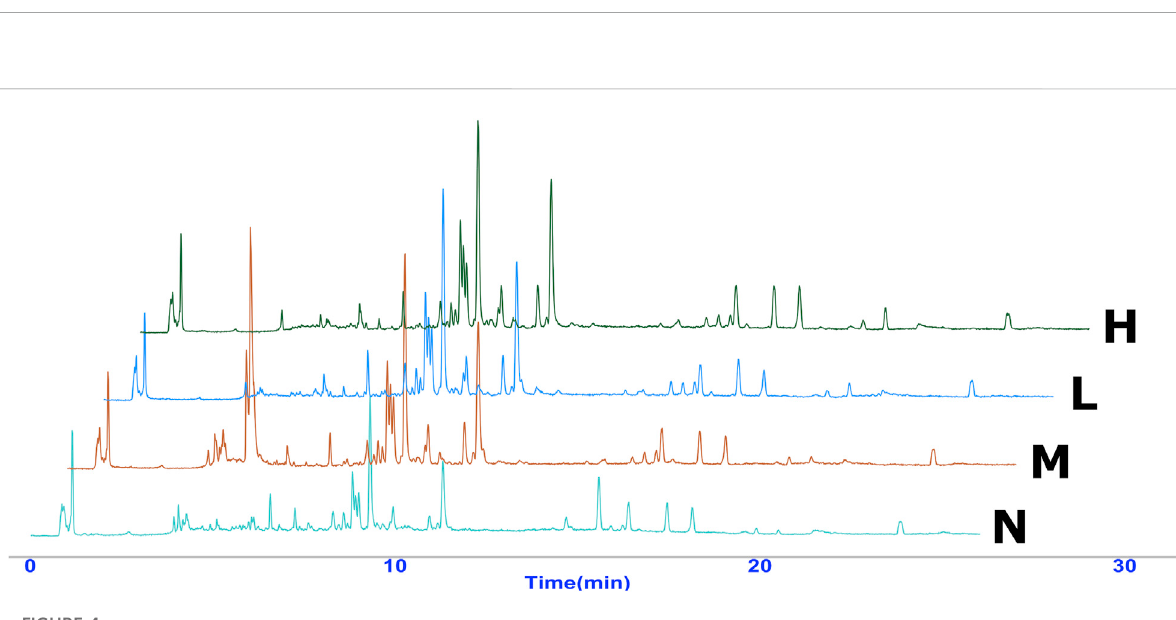
FIGURE 4 Overlaid representative UPLC-Exactive Plus Orbitrap Mass TIC chromatograms (positive ion) of the serum samples from the four groups, includingnormal(N),model(LPS100 μ g/kg,M),lowdosegroup(LPS100 μ g/kg+AG20 mg/kg,L)andhighdose(LPS100 μ g/kg+AG40 mg/kg,H)